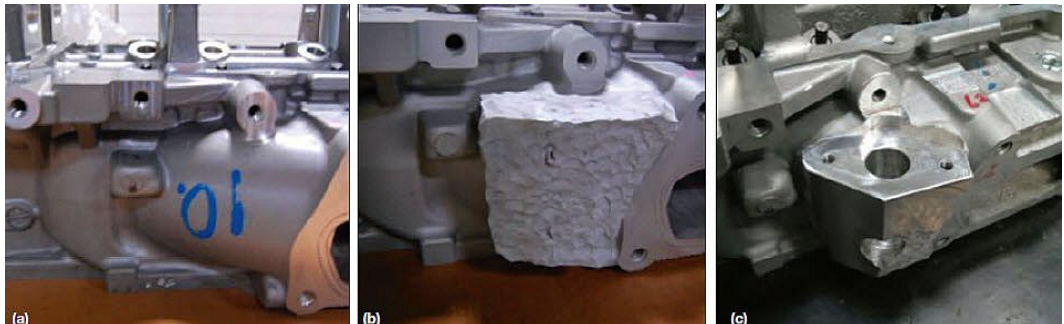
Figure 18. Additional feature added to a machine component by cold spray additive manufacturing: ( a ) before spraying; ( b ) after cold spray; ( c ) finished [62].